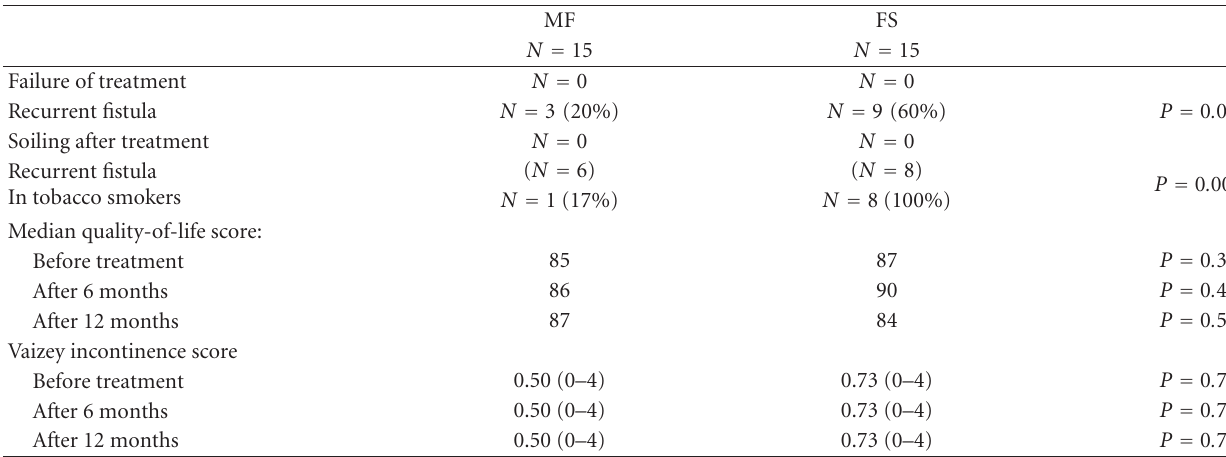
Table 2: Table Patients